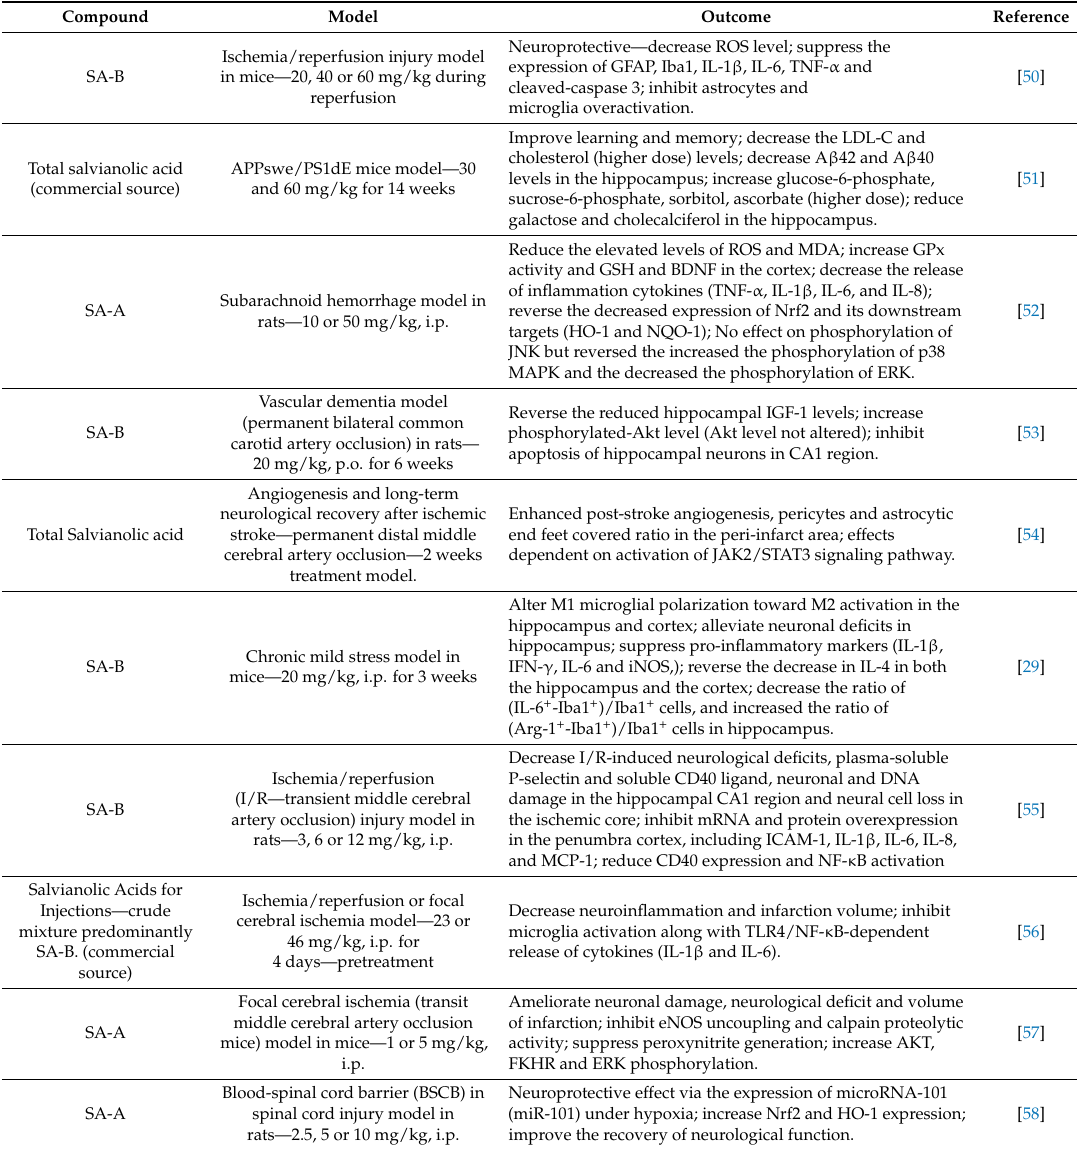
Table 2. In vivo neuroprotective effects of salvianolic